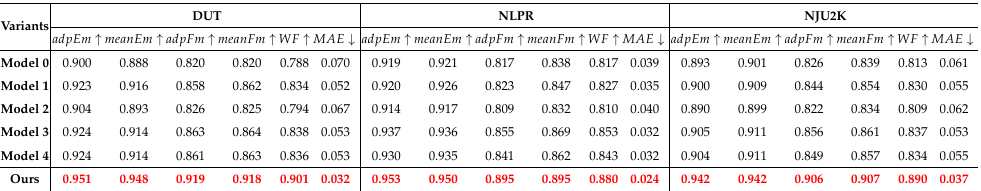
Table 2. Results of ablation studies. The best results are highlighted in red